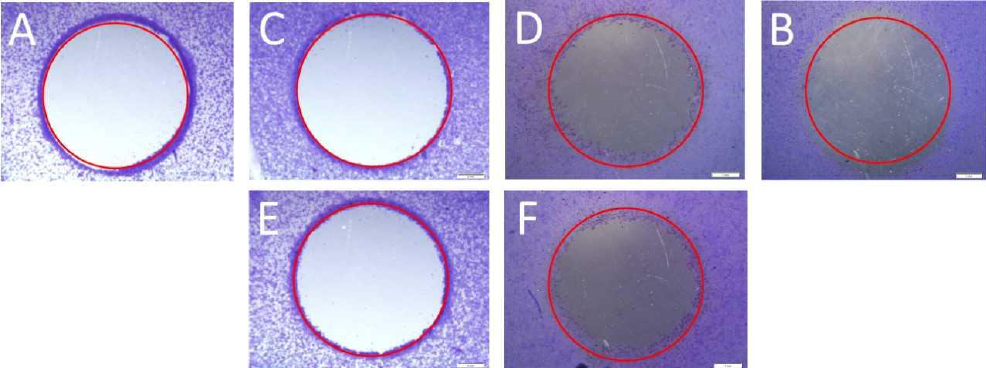
Figure 5. Circle assay; circle control: ( A )—HT29, ( B )—CCD 841 CoTr; control 24 h: ( C )—HT29 and ( D )—CCD 841 CoTr; circle after 24 h: ( E )—HT29 and ( F )—CCD 841 CoTr. Bar = 1 mm.